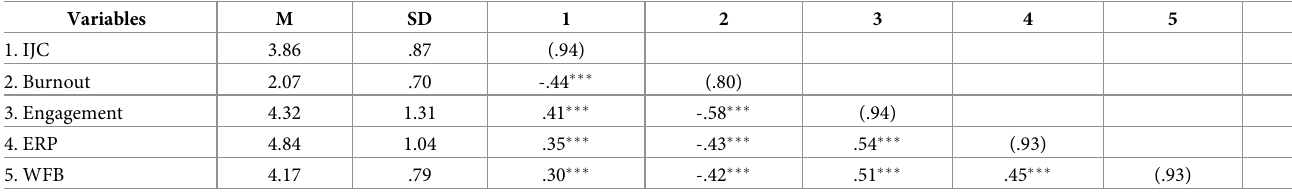
Table 1. The means, standard deviations, internal consistencies, and correlations between variables.